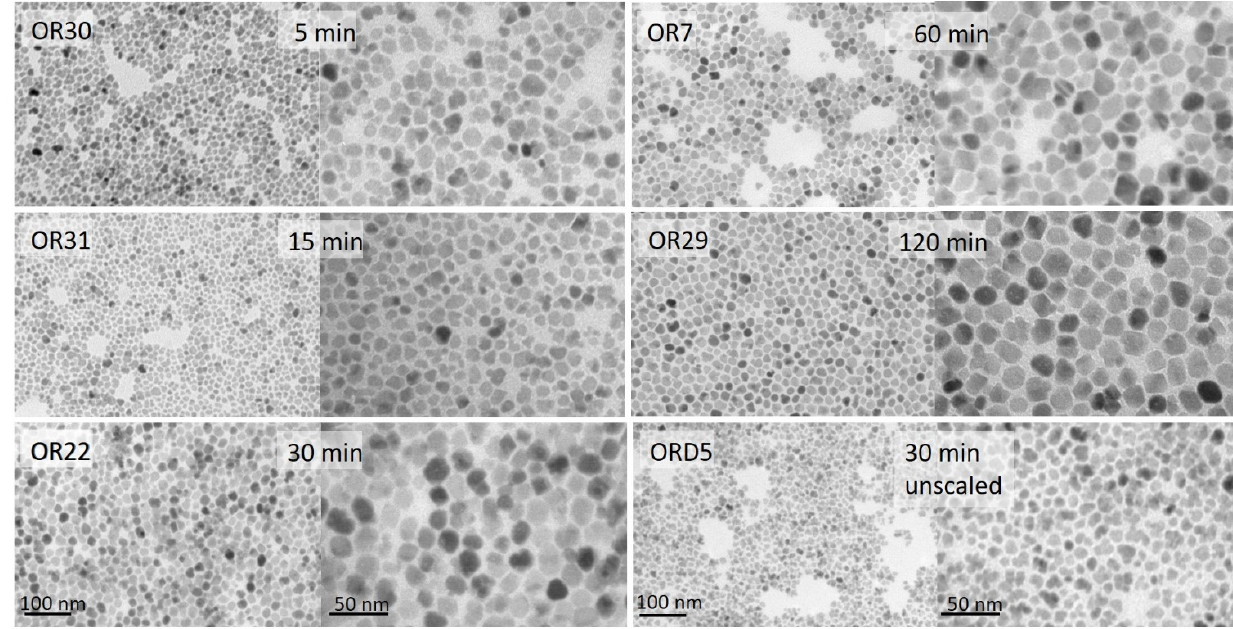
Figure 2. TEM images of one representative scaled-up sample heated for different times at the highest temperature and one unscaled sample (ORD5) heated for 30 min at the highest temperature.